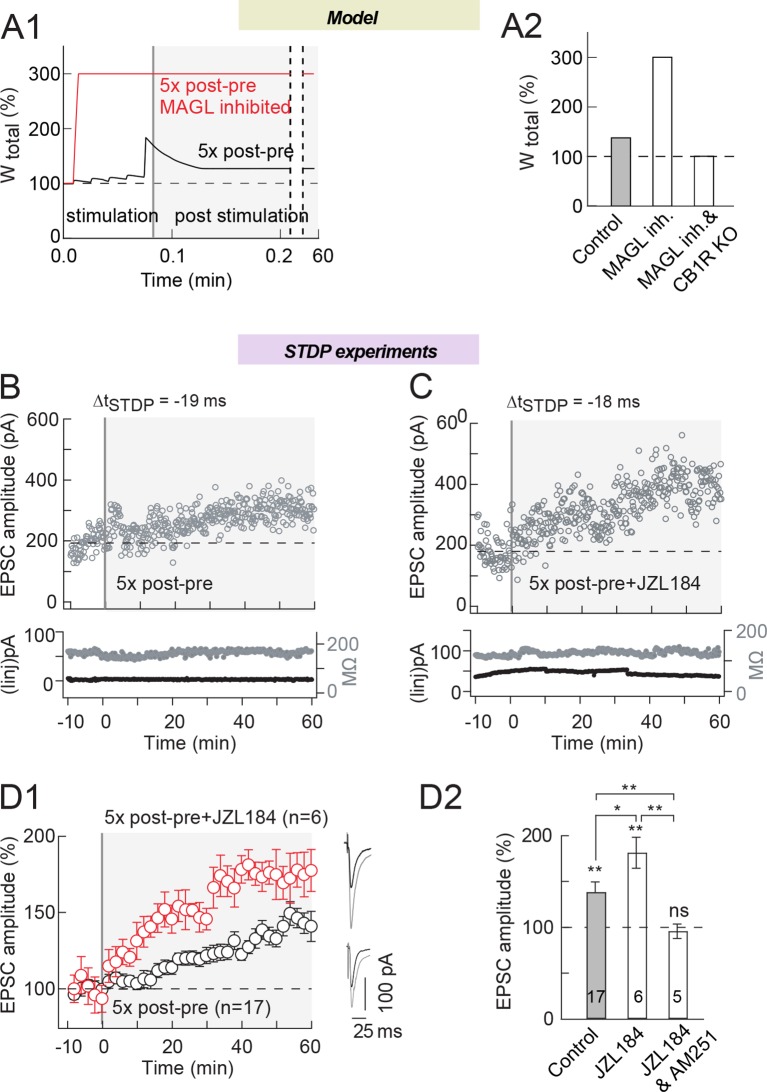
MAGL inhibition increases eCB-tLTP magnitude induced by 5
pairings.(A) Model prediction for eCB-LTP amplitude induced by
Npairings=5 post-pre pairings with
ΔtSTDP=-15 ms. (A1) In control (full black line),
the synaptic weight increases during the 5 s stimulation protocol (white
background) and stabilizes afterwards (gray background) to a moderate tLTP.
When eCB production is amplified in the model by MAGL inhibition and
DAG-Kinase activity (full red line), the amplitude of the tLTP resulting
from the same stimulation is drastically amplified. In the model, MAGL and
DAG-Kinase inhibition were simulated by fixing the value of the maximal
rates of each enzyme to 0 and 5%, respectively, of their default values
listed in Supplementary file 1C. (A2) Summary bar graph of the
tLTP amplitude predicted by the model for
Npairings=5 post-pre pairings,
ΔtSTDP=-15 ms. (B) Corresponding example of
experimental tLTP induced by 5 post-pre pairings. Top, EPSC strength before
and after pairings (before pairings: 145±4 pA; 45–55 min after pairings:
247±5 pA; increase of 70%). Bottom, time courses of Ri (before, 165±1 MΩ;
after, 170±1 MΩ; change of 3.0%) and injected current (Iinj) (before,
2±0.2 pA; after, 3±0.1 pA; change of 0.7%) for this cell. (C)
MAGL inhibition by JZL184 (1.5 μM) led to an increase of tLTP magnitude.
Example of tLTP induced by 10 post-pre pairings with bath-applied JZL184.
Top, EPSC strength before and after pairings (before pairings: 180±6 pA;
45–55 min after pairings: 412±7 pA; increase of 129%). Bottom, time courses
of Ri (before, 116±1 MΩ; after, 126±1 MΩ; change of 8.6%) and injected
current (Iinj) (before, -13±1 pA; after, -8±1 pA; change of 2.8%) for this
cell. (D) Summary of tLTP induced by 5 post-pre pairings in
control conditions and with JZL184 treatment. 10/17 and 6/6 cells showed
significant tLTP in control and in JZL184, respectively. Normality was
assumed for the ctrl 5x post-pre data (test not passed). (E)
Summary bar graph illustrates that tLTP magnitude was increased by MAGL
inhibition (JZL184) while prevented by CB1R inhibition (JZL184 1.5 μM +AM251
3 μM). Representative traces are the average of 15 EPSCs during baseline
(black traces) and 50 min after STDP protocol (grey traces). *p<0.05. ns:
non-significant.